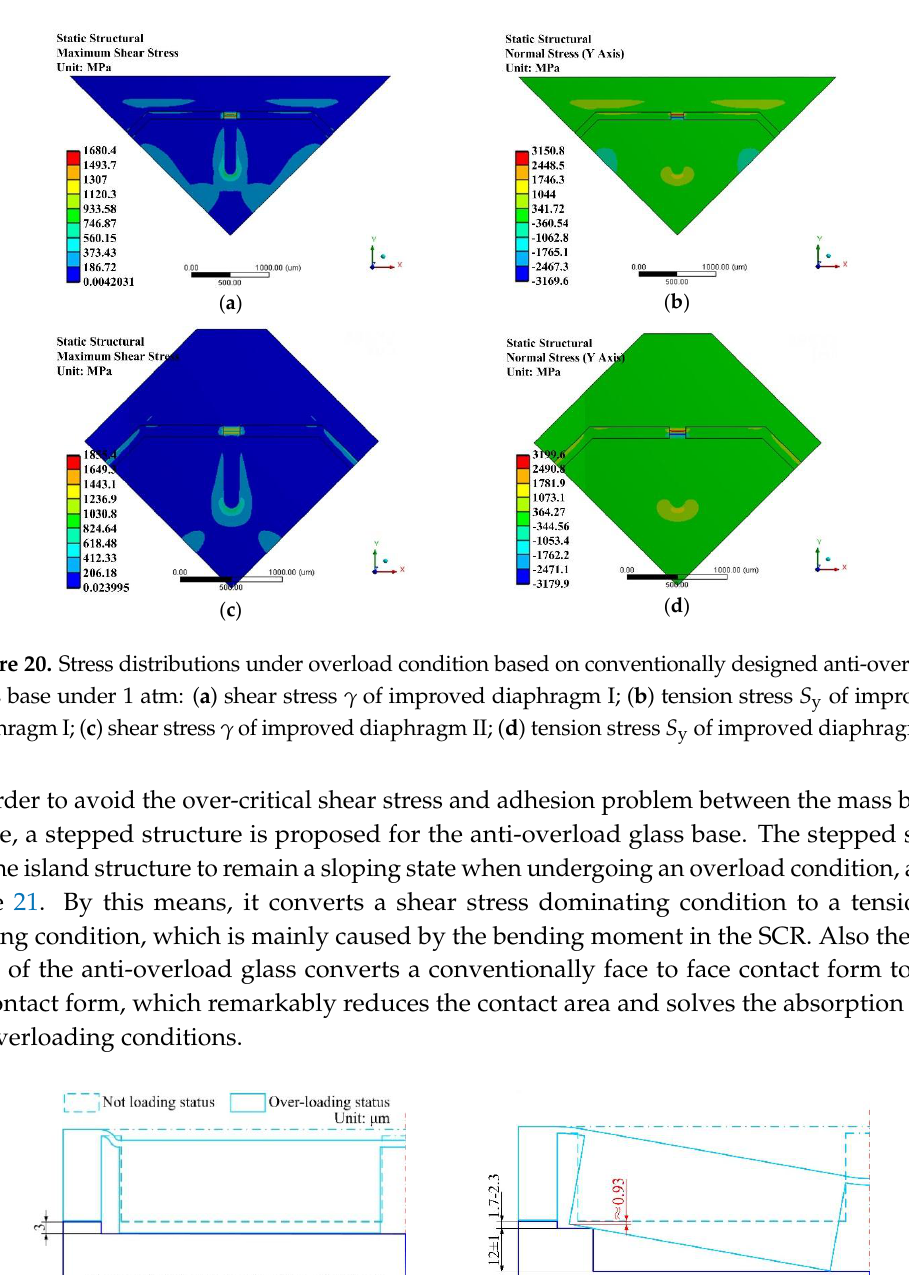
Figure 21. Working mechanism comparison between the conventional and stepped structures of anti- overload glass bases: ( a ) conventional anti-overloading design; ( b ) improved anti-overload design.